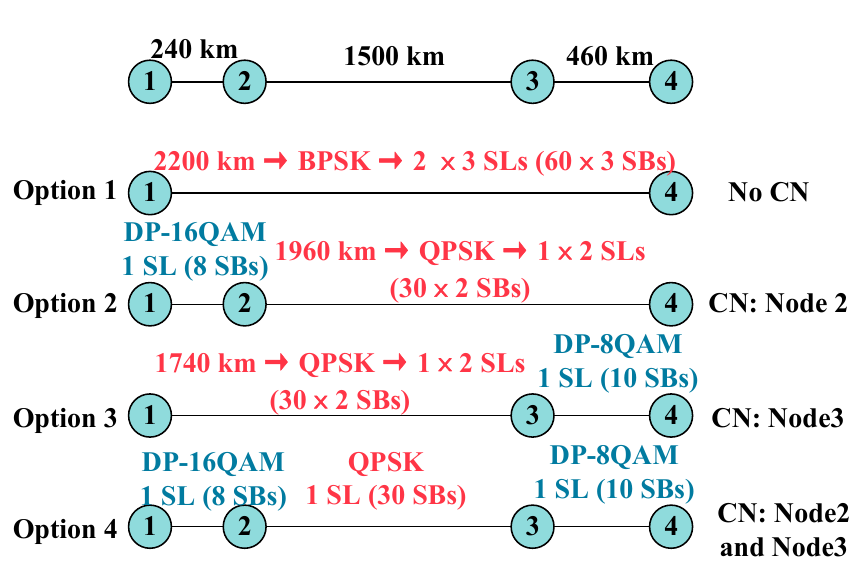
Figure 3. Example of different MF options for provisioning 6 Tb/s traffic requests on routing path 1 → 2 → 3 → 4.